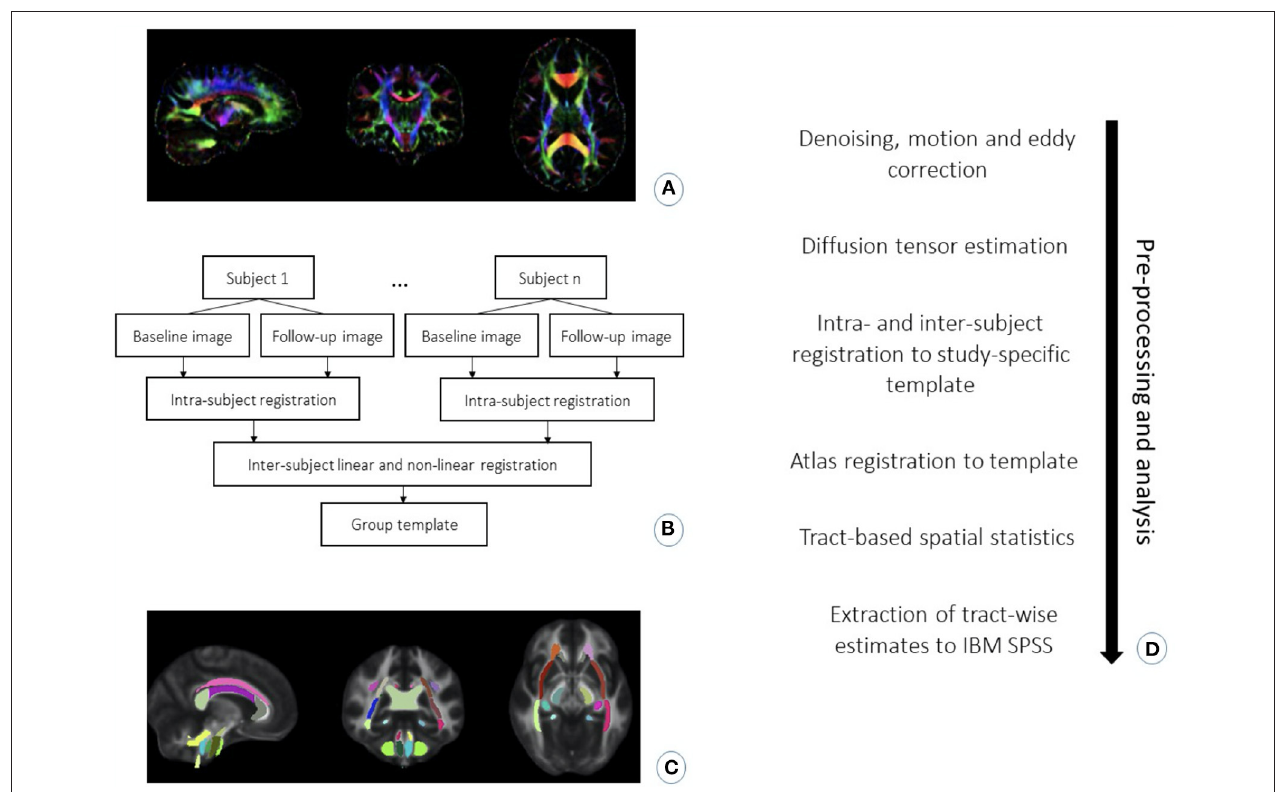
FIGURE 2 | Preprocessing and analysis steps: (A) Image of principal diffusion direction from diffusion tensor estimation. (B) Flowchart for the pipeline for registration of the DTI data into a study-specific template to align the images onto a common space. (C) Visualization of JHU atlas registration onto a study template, which was further used to locate the regions of interest. (D) Chronologically ordered listing of pre-processing and analysis steps used in the current